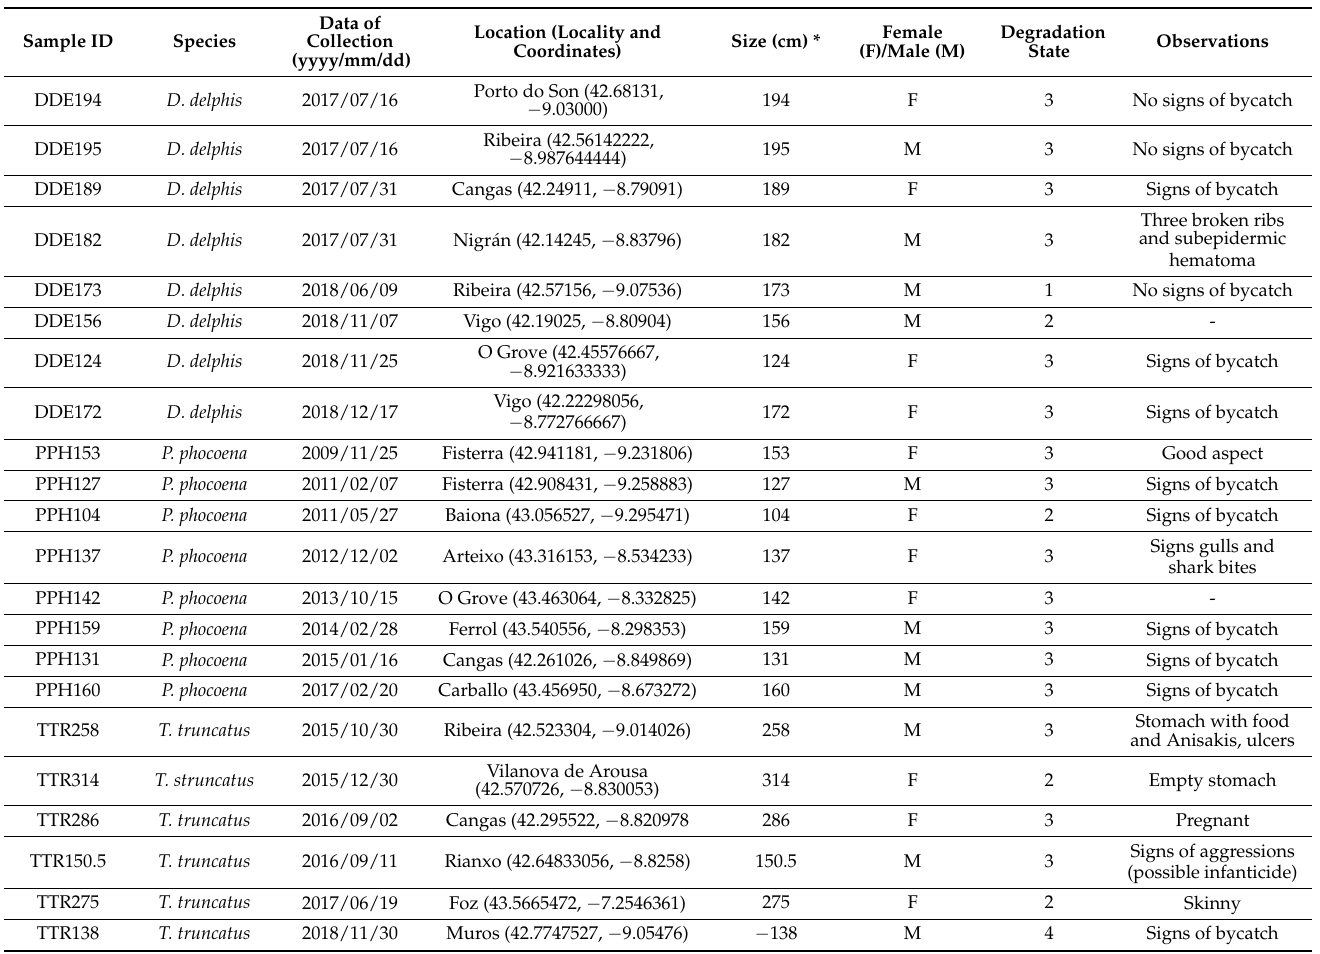
Table 1. Individual data of animals analysed for BMAA, DAB, and AEG. For each animal, samples of liver, kidney, and muscle were collected and analysed. Degradation state: 1 = found alive, dying immediately afterwards, 2 = freshly dead, 3 = moderate decomposition, 4 = advanced decomposition, 5 = skeletal remains. F = female, M =